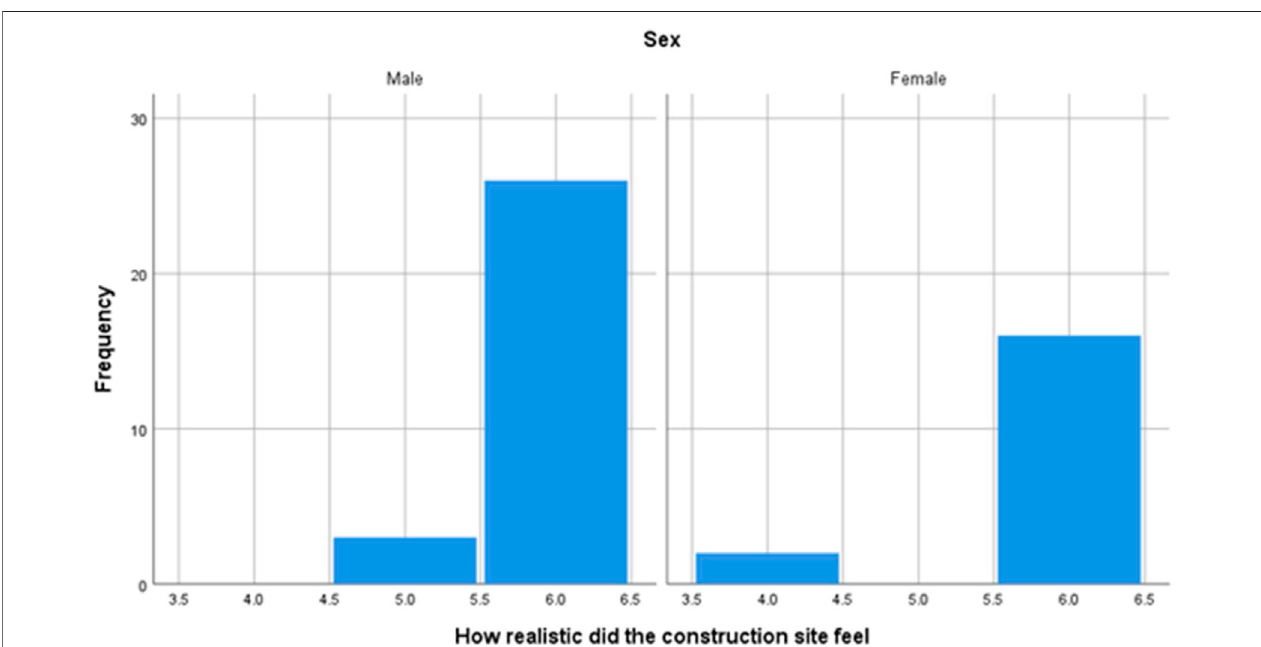
FIGURE 16 | Questionnaire participants results for how realistic the construction site felt.